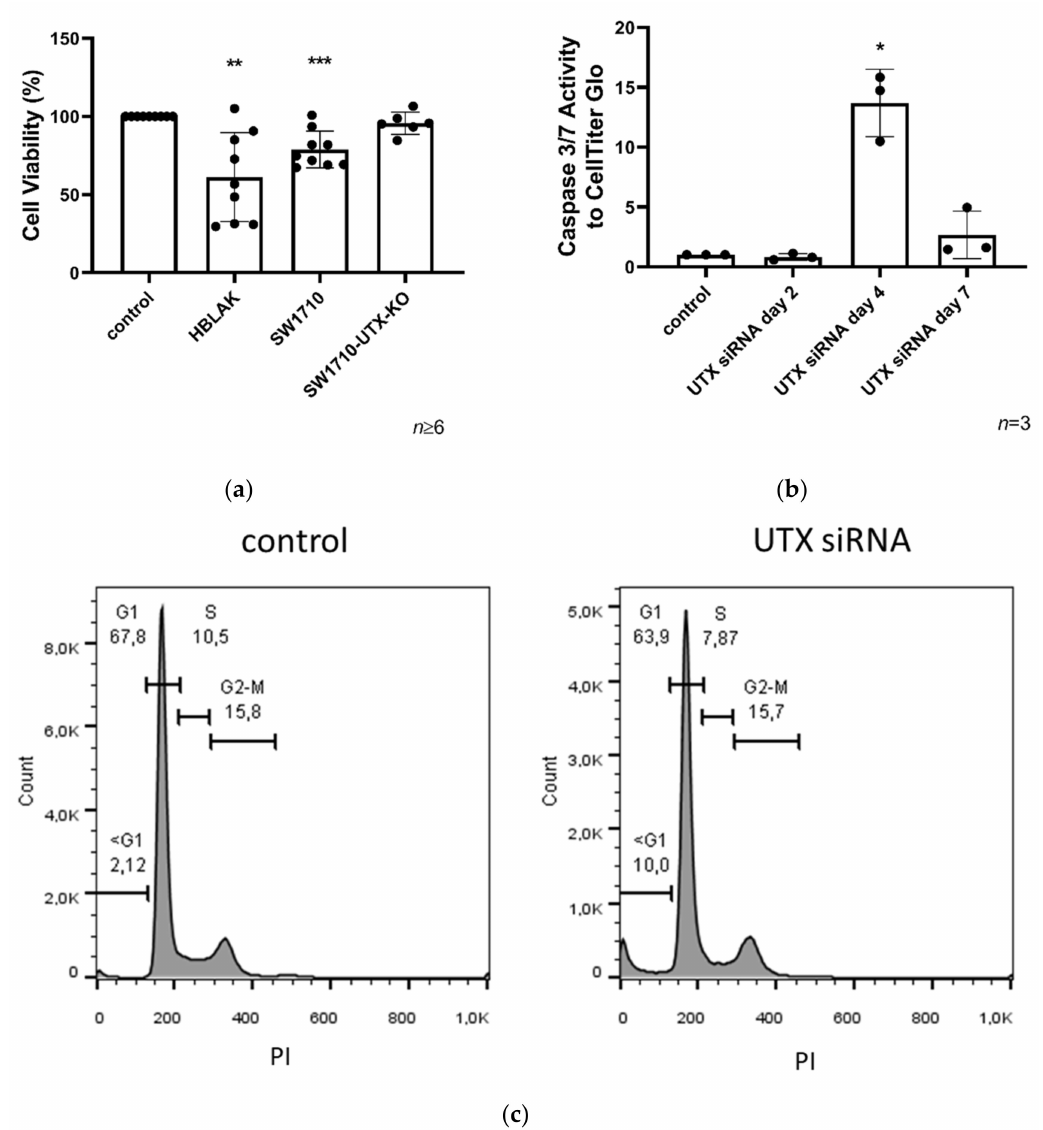
Figure 3. Cell viability in HBLAK and SW1710 UC cells 3 days after UTX knockdown. ( a ) Cell viability was measured via MTT on day 3 after UTX knockdown using siRNA 01 in HBLAK, SW1710 and SW1710-UTX-KO cells ( n = 6–9). ( b ) Time course of caspase-Glo 3 / 7 activity relative to total viable cells measured by CellTiter-Glo assay following UTX knockdown in HBLAK cells ( n = 3). ( c ) Cell cycle profile in HBLAK 2 d after UTX knockdown showing an increased sub-G1 fraction and a reduced G1 fraction. Note the lack of change in the G2 / M fraction. Statistics were performed with a one sample t test against the set value of 100 against the untreated control (* p < 0.05; ** p < 0.01; *** p <